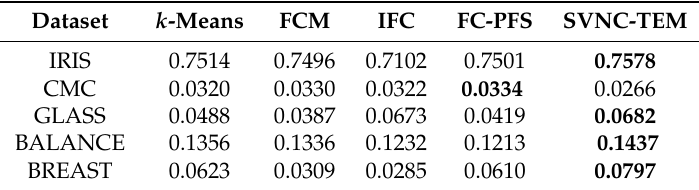
Table 3. The NMI for different algorithms on different